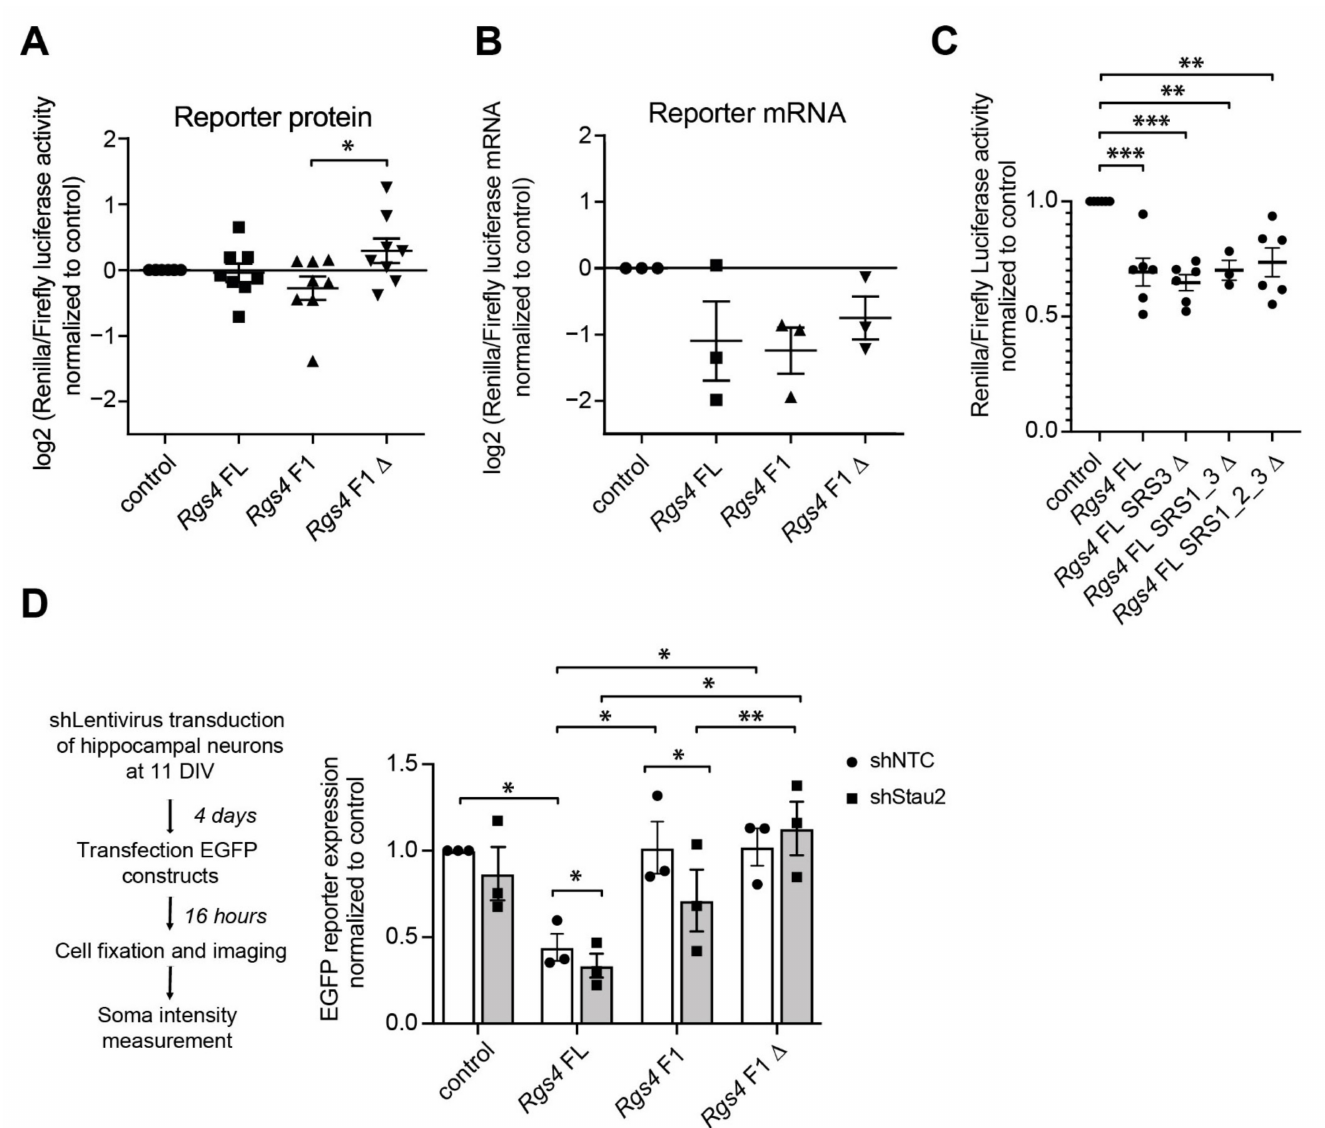
Figure 4. Lack of Stau2 significantly reduces GFP reporter expression in primary neurons. ( A ) Luciferase (RRL/FFL) activity in primary rat cortical neurons at 7+1 DIV transfected with Rgs4 3 (cid:48) -UTR constructs or control (no UTR). All data is normalized to control. ( B ) Luciferase RRL mRNA levels in primary rat cortical neurons at 7+1 DIV transfected with Rgs4 3 (cid:48) -UTR constructs or control (no UTR) normalized to FFL mRNA and to control. Symbols represent the individual conditions in ( A , B ). ( C ) Luciferase (RRL/FFL) activity in primary rat cortical neurons at 7+1 DIV transfected with the indicated control (no UTR) or Rgs4 FL constructs with the described SRS deletions ( ∆ ) constructs [19]. All data is normalized to control. Unpaired student’s t -test. ( D ) Scheme of the experiment (left) and quantification of eGFP fluorescence intensity in the cell body of hippocampal neurons at 15 DIV, co-transfected at 14+1 DIV with the indicated Rgs4 3 (cid:48) -UTR or control (no UTR) constructs in Stau2 KD (shStau2) or mock conditions, respectively. Mann-Whitney-test ( A ), one-sample t -test ( B ), one-way ANOVA with subsequent Tukesy’s multiple comparisons test ( C ) as well as paired Student’s t -test ( D ). Error bars from ( A , C ) are SEM from at least 6 independent biological replicates. Error bars from ( B , D ) are SEM from ≥ 3 independent biological replicates. Asterisks represent p -values * p < 0.05, ** p < 0.01, *** p < 0.001. DIV days in vitro. FL, full length; F1 fragment 1; F1 ∆ fragment 1 with a 20 nt